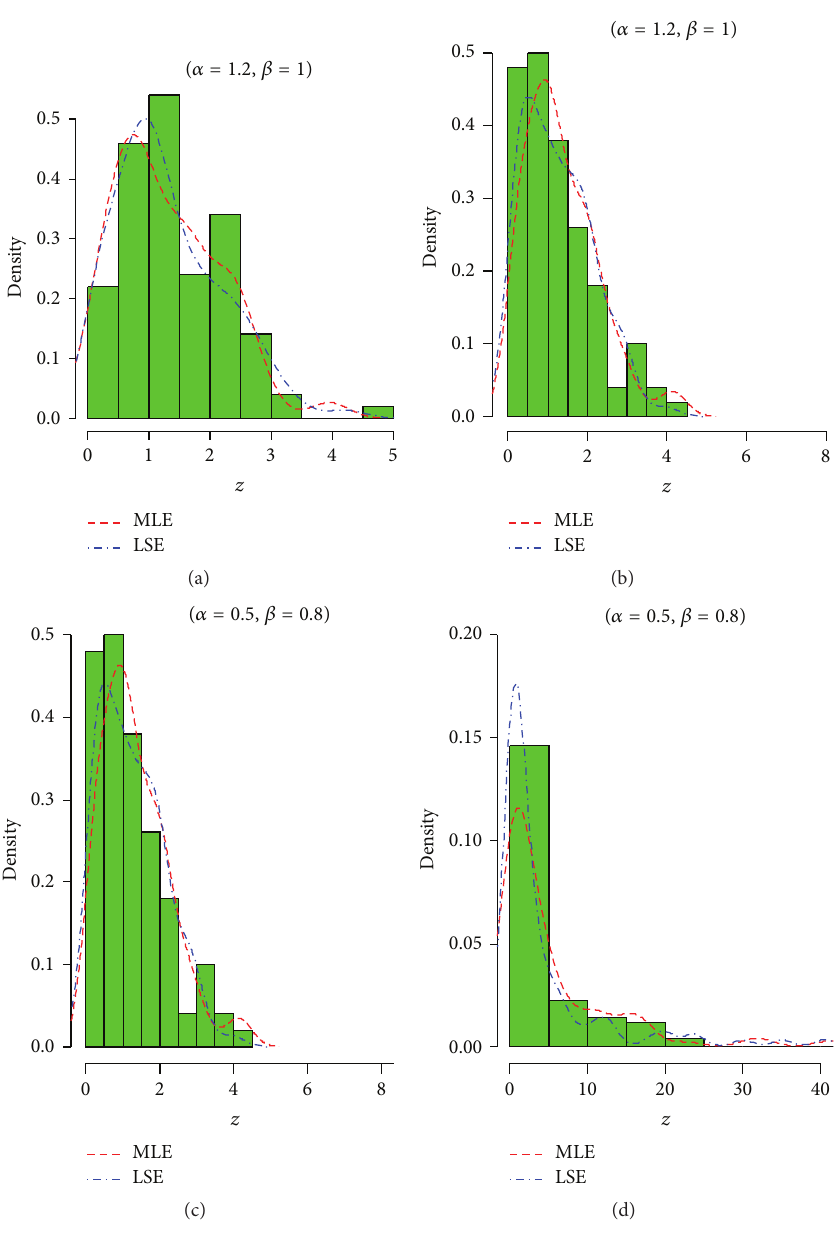
Figure 6: Fitted density curves based on